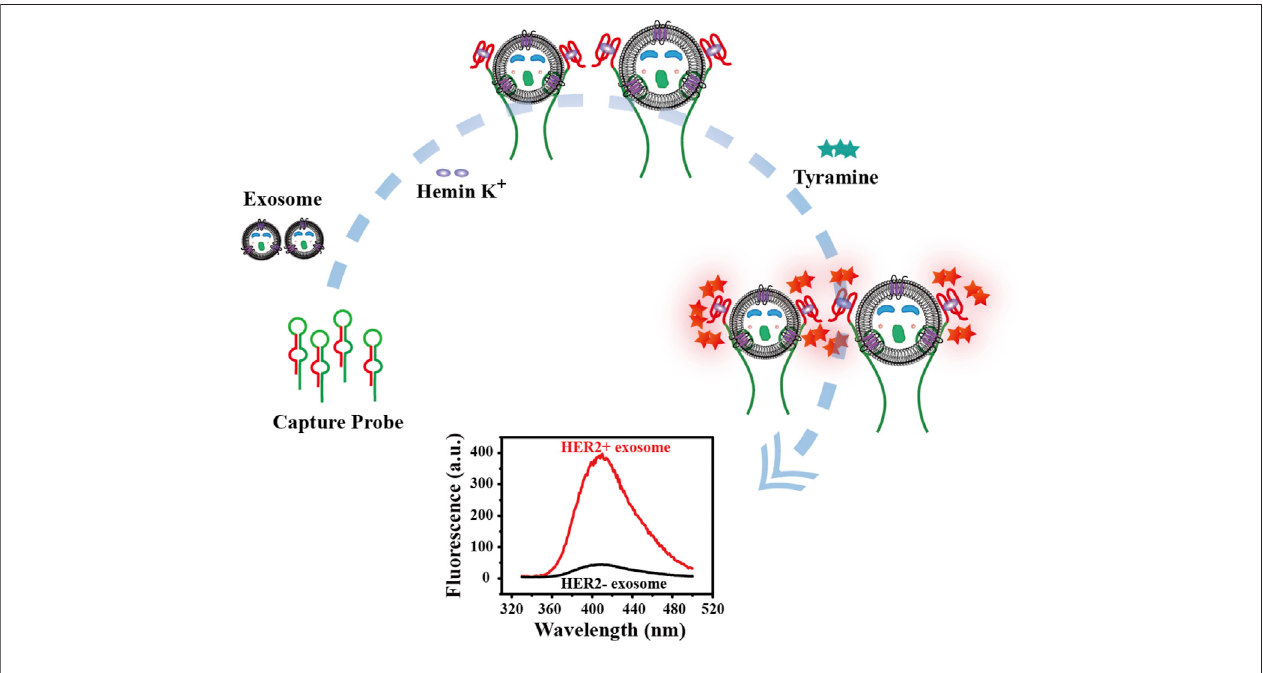
SCHEME 1 | Schematic diagram of principle for detection of tumor cell-derived exosomes.